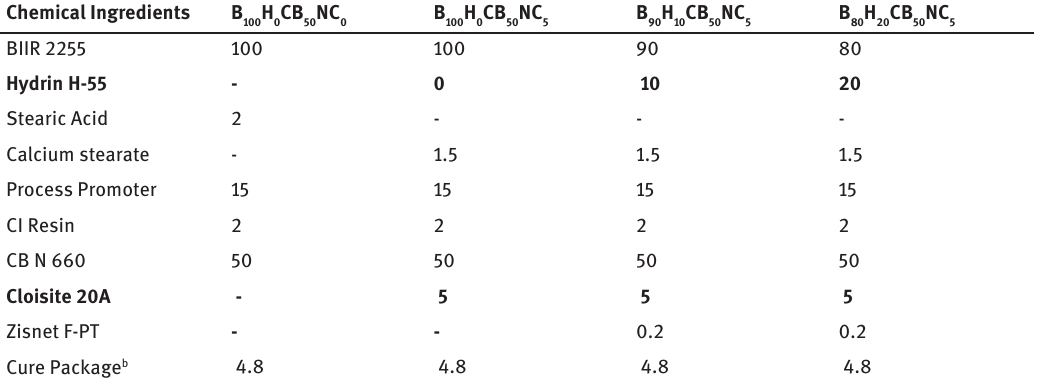
Table 1: Compound formulation a (all ingredients are measured in phr, parts per 100 g of rubber). Chemical